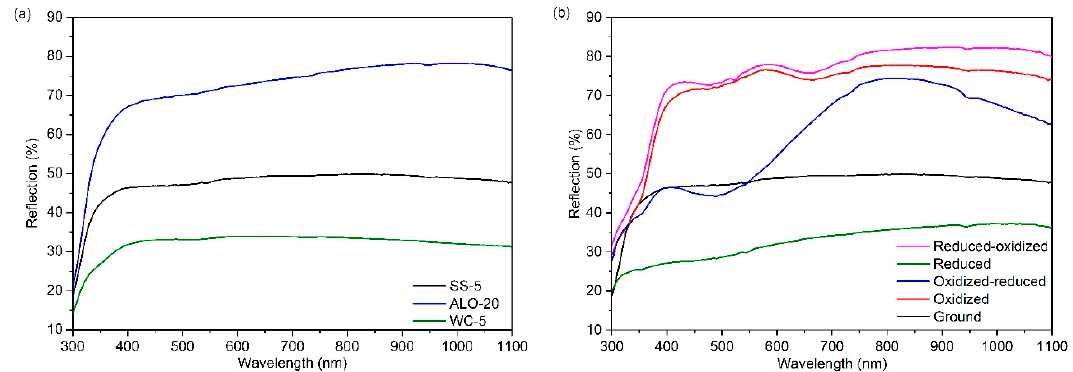
Figure 4. Optical reflection spectra of samples ball-milled in different vials ( a ) and of ground and heat-treated samples ball-milled in stainless steel vial (SS-5) ( b